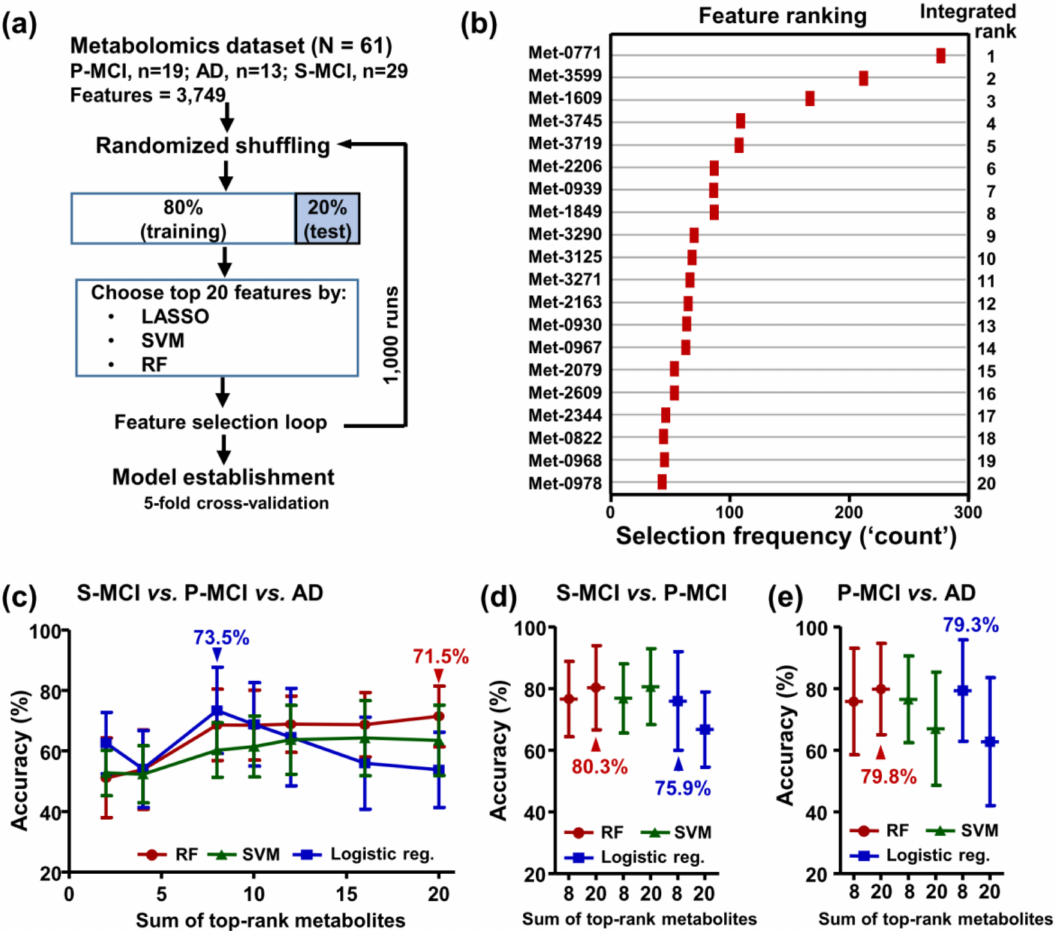
Figure 2. Model development and evaluation for biomarker discovery involving the risk assessment of AD conversion. ( a ) The workflow of the feature selection used to establish a signature panel for differentiating the S-MCI, P-MCI, and AD